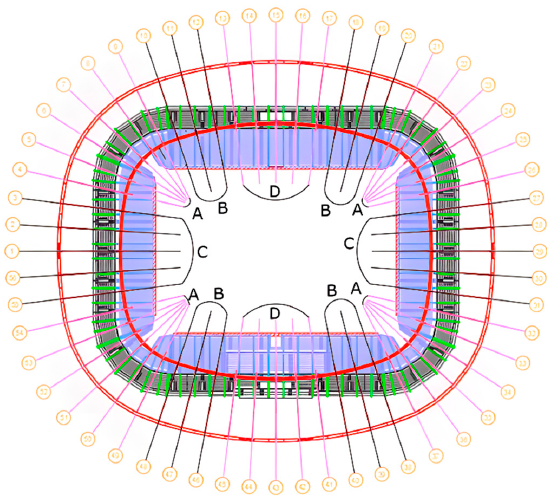
Figure 23. Section division of cable net.